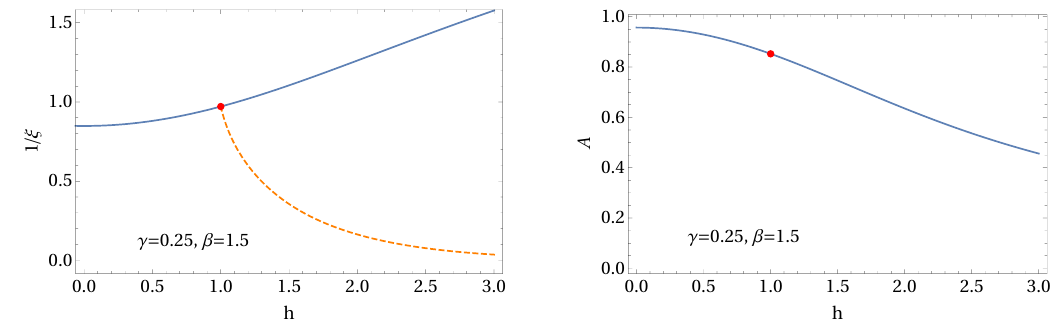
Figure 3: The inverse correlation length (left panel) and the prefactor (right panel) for different values of magnetic field h . Blue solid curves correspond to Eq. (87) [ Eq. (88) ] for h < 1 and Eq. (84) [ Eq. (85) ] for h > 1, for the left [ right ] panels, respectively. The orange line shows formal use of Eq. (87) for the region h >